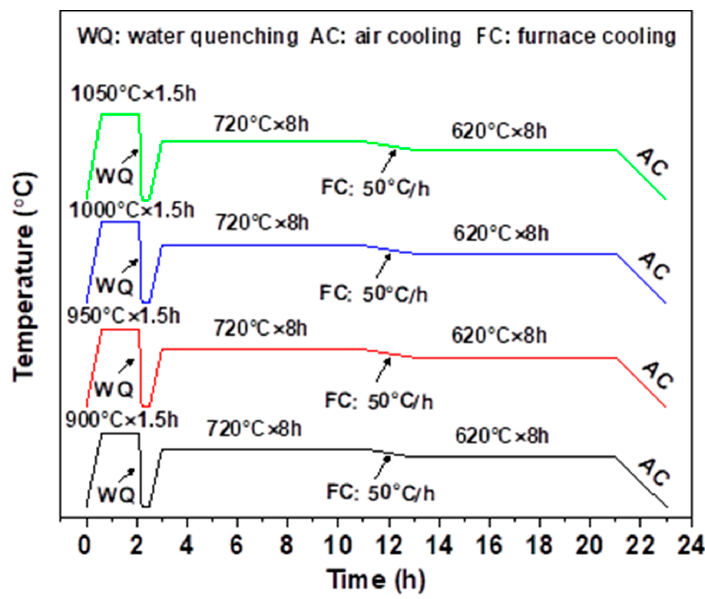
Figure 1. Schematic illustrations of the heat treatment cycles performed in this study. The feedstock powders were characterized with field emission scanning electron microscopy (FESEM, JEOL, Tokyo, Japan) and electron backscatter diffraction (EBSD, Oxford, UK). The EBSD was taken by using a 0.2 µm step size. After cold spray deposition and heat treatment, the coating microstructure was measured by using optical microscopy (Zeiss, Jena, Germany). Coating porosities were measured with the ImageJ software (Version 1.53). The cross-sectional microstructures of the coatings were analyzed by using FESEM and EBSD. Microhardness values were evaluated by using a Vickers hardness tester (Future-Tech, Kanagawa, Japan) under a load of 500 gf. The dimensions of the tensile specimens of the freestanding IN718 coatings are shown in Figure 2. The tensile tests were carried out with an Instron testing machine (Zwick Roell Group, Ulm, Germany) with an extension rate of 0.4 mm/min. Figure 2. Dimensions of the tensile samples of the IN718 coatings. 3. Results and Discussions 3.1. Powder Characterization Figure 3a shows the SEM micrograph of the IN718 powder and the inset is an enlarged view of most of the particles falling within the size range of 20–45 µm, and the average particle size is 32 µm. Figure 3c shows the Inverse Pole Figure (IPF) micrograph